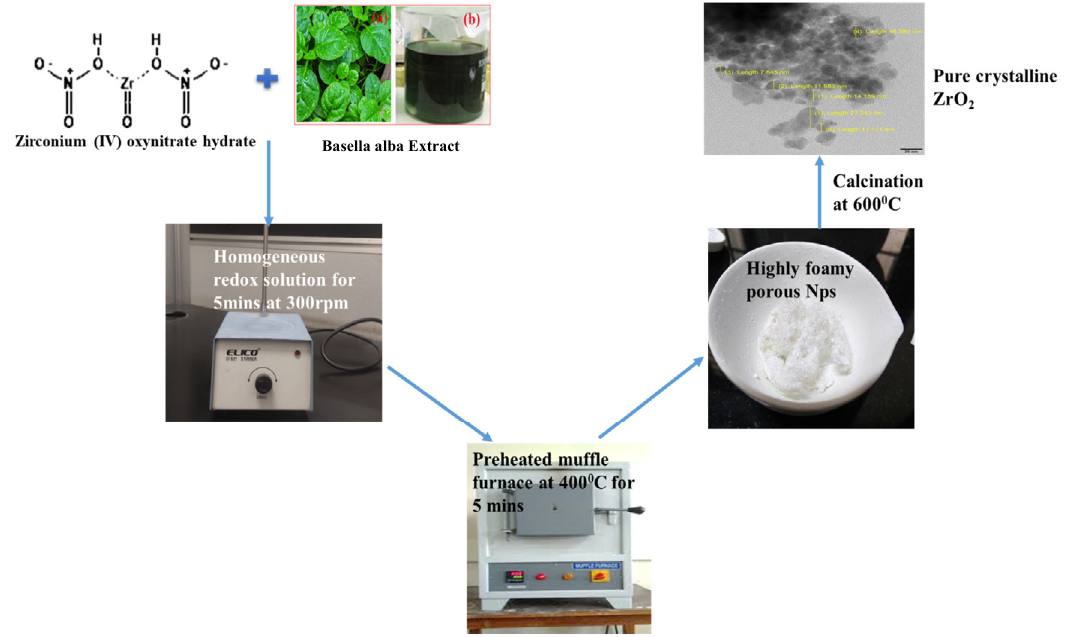
Scheme.2. The scheme for the preparation of ZrNP